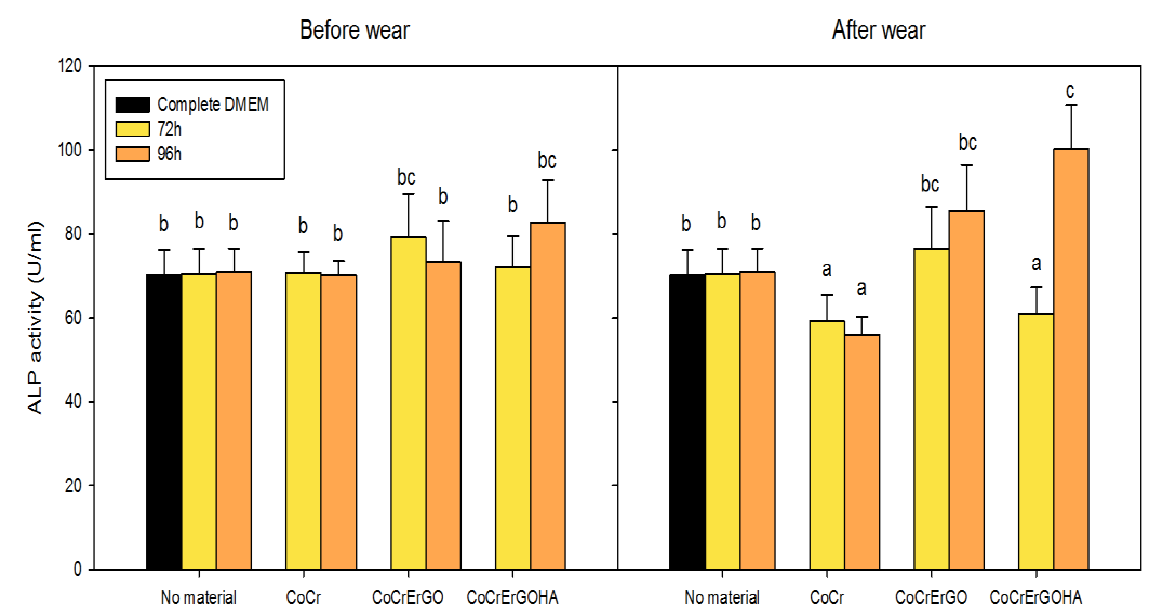
Figure 6. The effect of macrophage supernatants on ALP activity in pre-osteoblast MC3T3E-1. The cells were incubated with an osteogenic medium for 10 days and an additional 24 h with macrophage supernatants. CoCr after wear-assay caused inhibition in ALP activity that was reverted by ErGO and ErGOHA. The results are expressed as 𝑥̃ ± SD. Samples sharing identical letters do not have statistically significant differences with a p < 0.01.